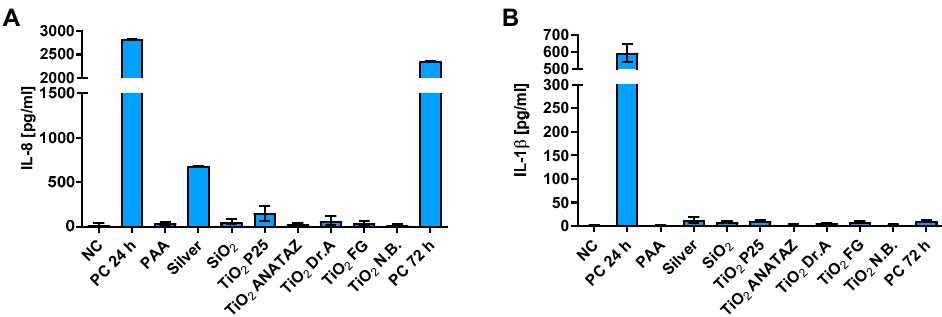
Figure 9. Resolution of ( A ) IL-8 and ( B ) IL-1 β cytokine secretion 48 h after 24 h incubation of THP-1 macrophages with 50 µ g mL − 1 of NPs (25 µ g mL − 1 for silver) as determined with ELISA. A concentration of 100 ng mL − 1 LPS for IL-8 or 200 µ g mL − 1 crystalline SiO 2 NPs for IL-1 β were used as a positive control with 24 h or 72 h incubation, for PC 24 h and PC 72 h, respectively. Please note the different scale on the y-axes for panels A and